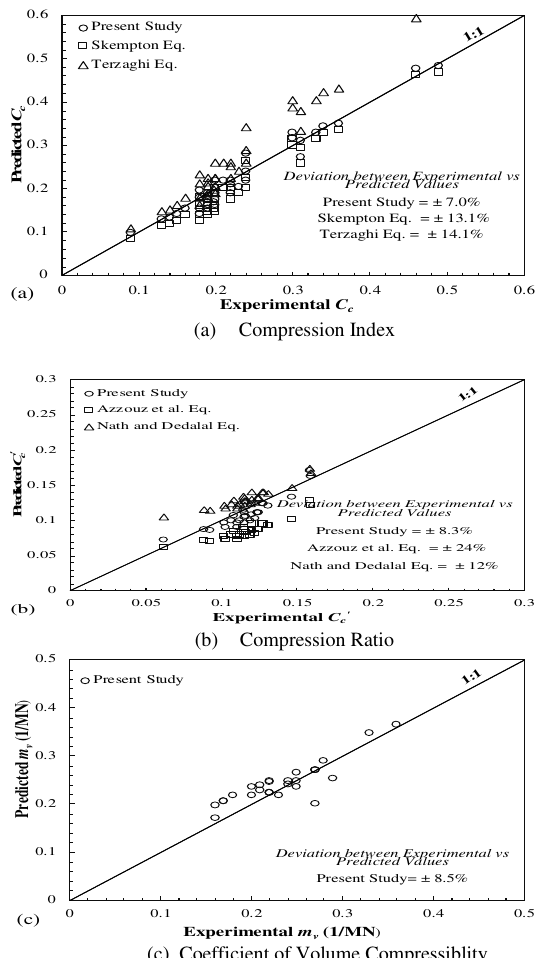
Fig. 5: Comparison between Experimental Vs Predicted Values of Compression Index Based on Liquid Limit predicted from equations 6, 7, and 8 were in the range